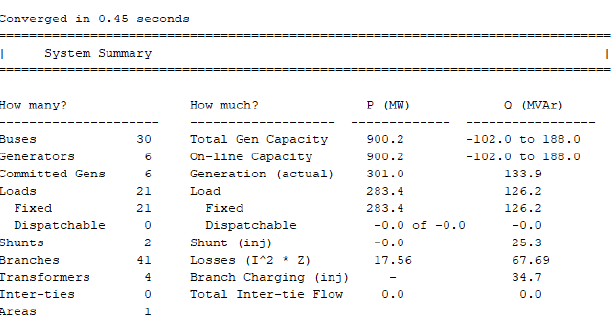
Figure 1. System summary and load flow analysis using Gauss – Seidel numerical method.